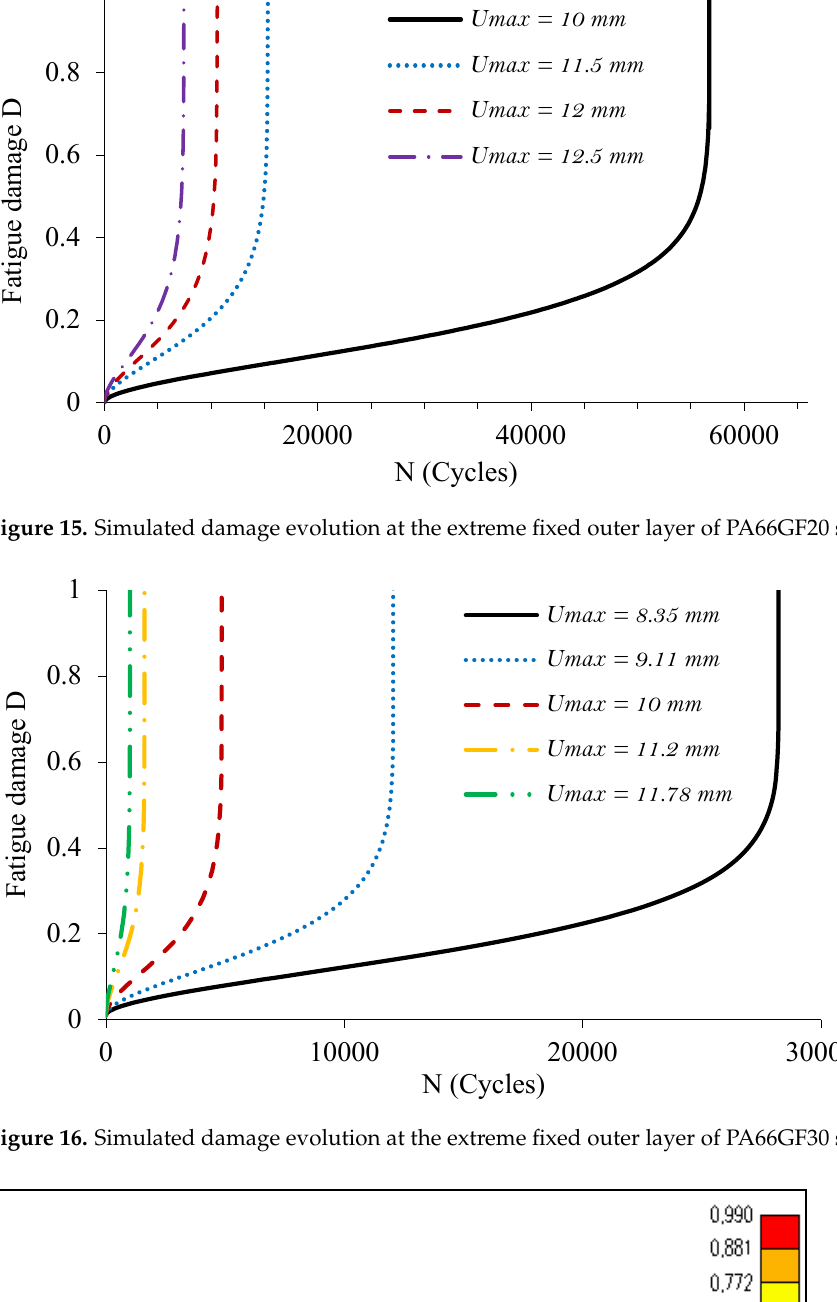
19 of 23 Figure 14. Simulated force-cycle history for PA66GF30 specimens. Table 7. Experimental and numerical number of cycle to failure of PA66GF30. Imposed Displacement